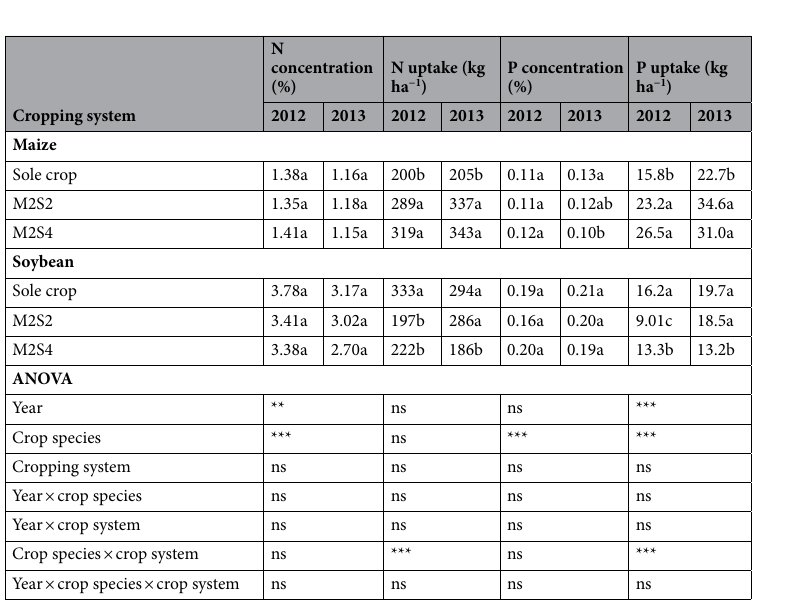
Table 2. N and P concentration and uptake of maize and soybean grown under sole cropping and intercropping systems in 2012 and 2013. M2S2—two rows of maize intercropped with two rows of soybean; M2S4—two rows of maize intercropped with four rows of soybean. *, significant at 0.05 level; **, significant at 0.01 level; ***, significant at 0.001 level; ns, no significant difference. The mean values indicated by a different letter in the same column are significantly different at the 5% level using LSD.